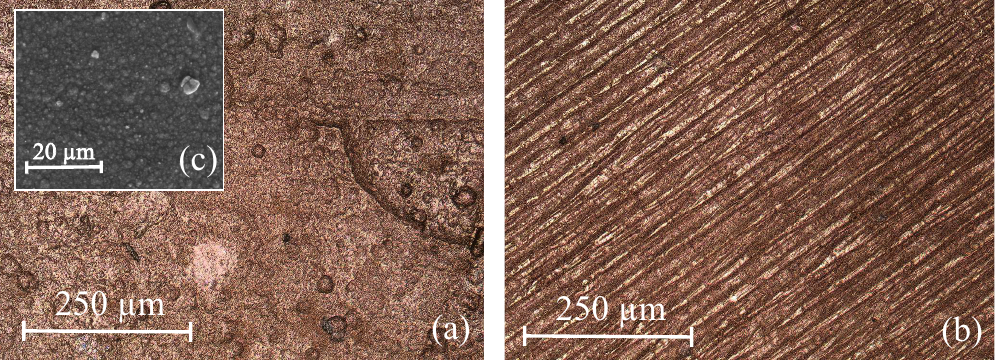
Figure 6. Close-up view of the inner surfaces of the fabricated waveguides. Compared to the standard printing approach with epoxy resin ( b ), the ceramic waveguide ( a , c ) features a higher surface roughness (epoxy resin: R q,e = 0.53 µm, ceramic: R q,c = 2.43 µm). However, when comparing the geometry of the printed samples (Figure 7) and not just the surface quality, it is clear to see that both samples are comparable and do not deviate much from the CAD file (Figure 1). Considering five printed waveguides and comparing their geometric dimensions, the ceramic waveguides feature a dimensional accuracy of ± 0.05 mm in the xy-plane and ± 0.3 mm in z-direction. The epoxy resin printed waveguides feature a dimensional accuracy of ± 0.02 mm in the xy-plane and ± 0.1 mm in z-direction, respectively. The obtained parameters are, therefore, within the specifications of the used DLP-printer (xy-resolution: 0.05 mm, z-axis accuracy: 0.2 mm) [44].